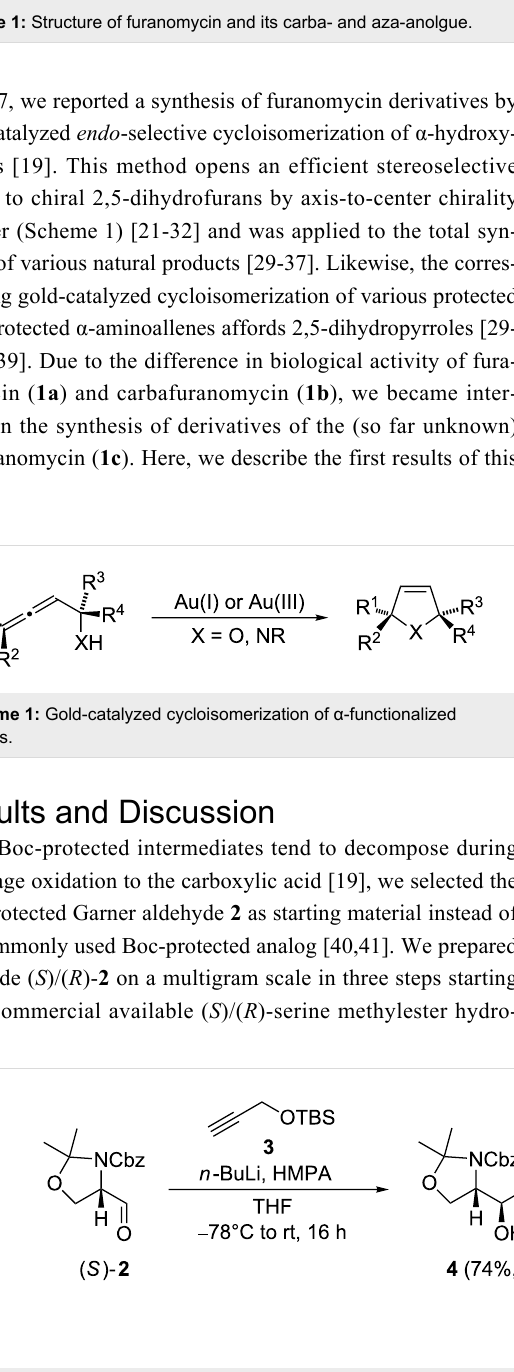
Scheme 2: Synthesis of propargylic electrophiles 5 .